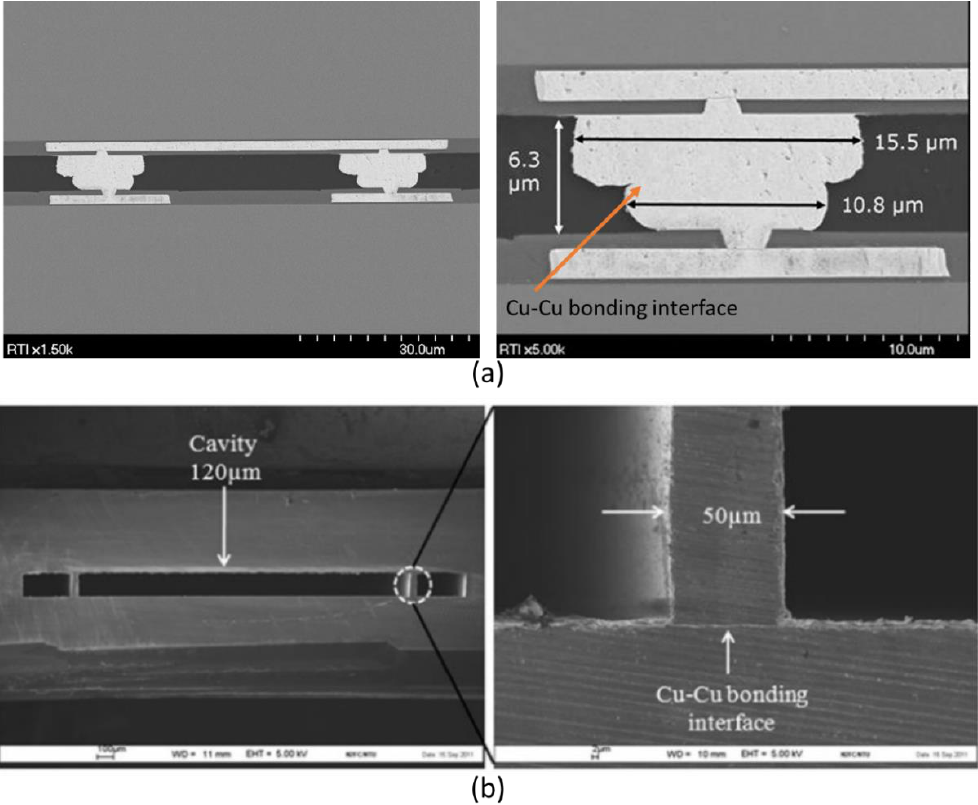
Figure 15. ( a ) Scanning electron microscope (SEM) micrographs of copper (Cu)-Cu bonded interconnect; ( b ) SEM micrographs of Cu-Cu bonded hermetic seal [160]. Figure 15b reprinted with permission from Microsystem Technologies.